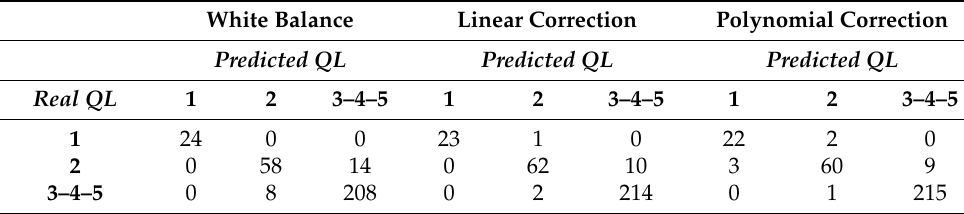
Table 4. Confusion Matrices obtained by the classification working on the datasets coming from the three different color correction models and with the task of separating marketable product (QL 5-4-3) from the edible (QL 2) and from the waste (QL 1) ones.